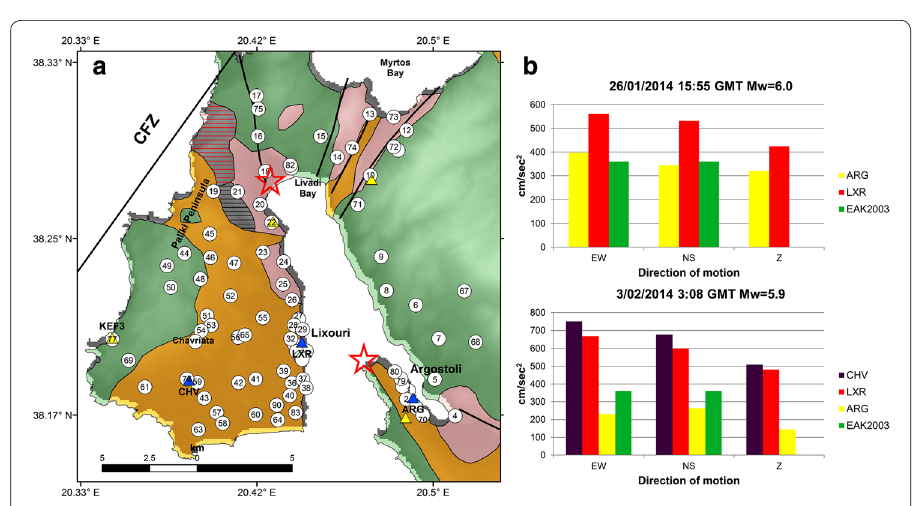
Fig. 3 a Locations of the 82 microtremors measurements the instrumentation in Cephalonia. Numbers within symbols denote the code adapted to each measurement during the field experiment. Hollow red stars denote the epicenters of the main-shocks. The legend for the geological settlement is presented in Fig. 2. b Diagram showing the peak ground acceleration (PGA) values recorded in Cephalonia during the two main- shocks in comparison with the [9] provisions for the